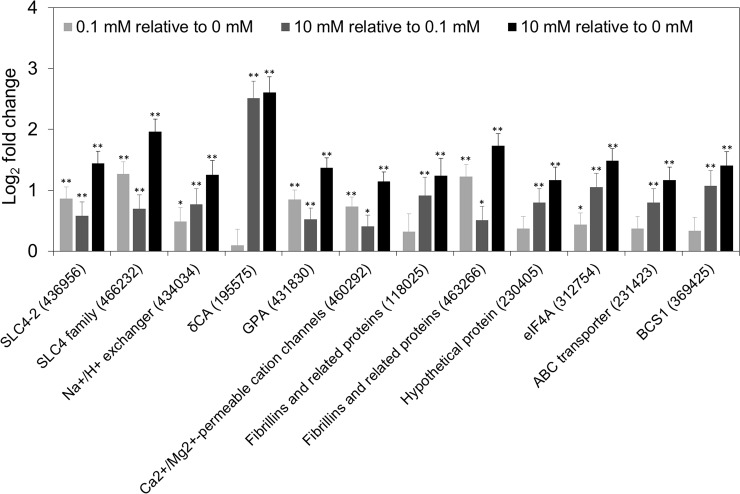
Putative biomineralization-related genes in DEGs at different calcium concentrations.The log2 fold changes of the genes are shown as a bar chart (log2FC; ± SE, light gray: [Ca2+] 0.1 mM relative to [Ca2+] 0 mM, dark gray: [Ca2+] 10 mM relative to [Ca2+] 0.1 mM, black: [Ca2+] 10 mM relative to [Ca2+] 0 mM). The gene IDs in the bar chart are in the following order: SLC4-2 (c31857_g11_i1), SLC family (c25647_g1_i1), Na+/H+ exchanger (c31114_g3_i2), delta CA (c24914_g1_i2), calcium-binding GPA (glutamic acid, proline and alanine) protein (c20552_g1_i1), Ca2+/Mg2+ permeable cation channels (LTRPC family) (c30953_g1_i11), fibrillins and related proteins containing a Ca2+-binding epidermal growth factor (EGF)-like domain (JGI ID 118025; c28155_g1_i1), fibrillins and related proteins containing Ca2+-binding EGF-like domain (JGI ID 463266; c28980_g1_i1), hypothetical protein (c34539_g1_i1), eukaryotic initiation factor 4A (eIF4A) (c22513_g1_i1), ABC transporter (c34539_g1_i1), and putative mitochondrial chaperone BCS1 (c23862_g2_i1). Asterisks represent significant expression change (*p < 0.05, **p < 0.005).